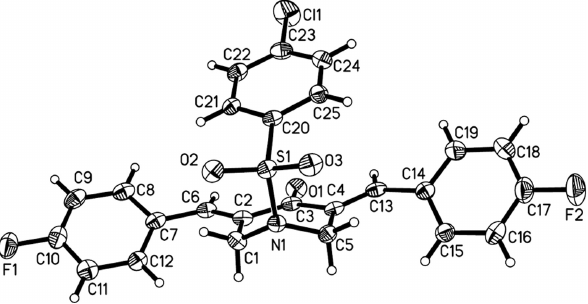
Table 1: Data collection and